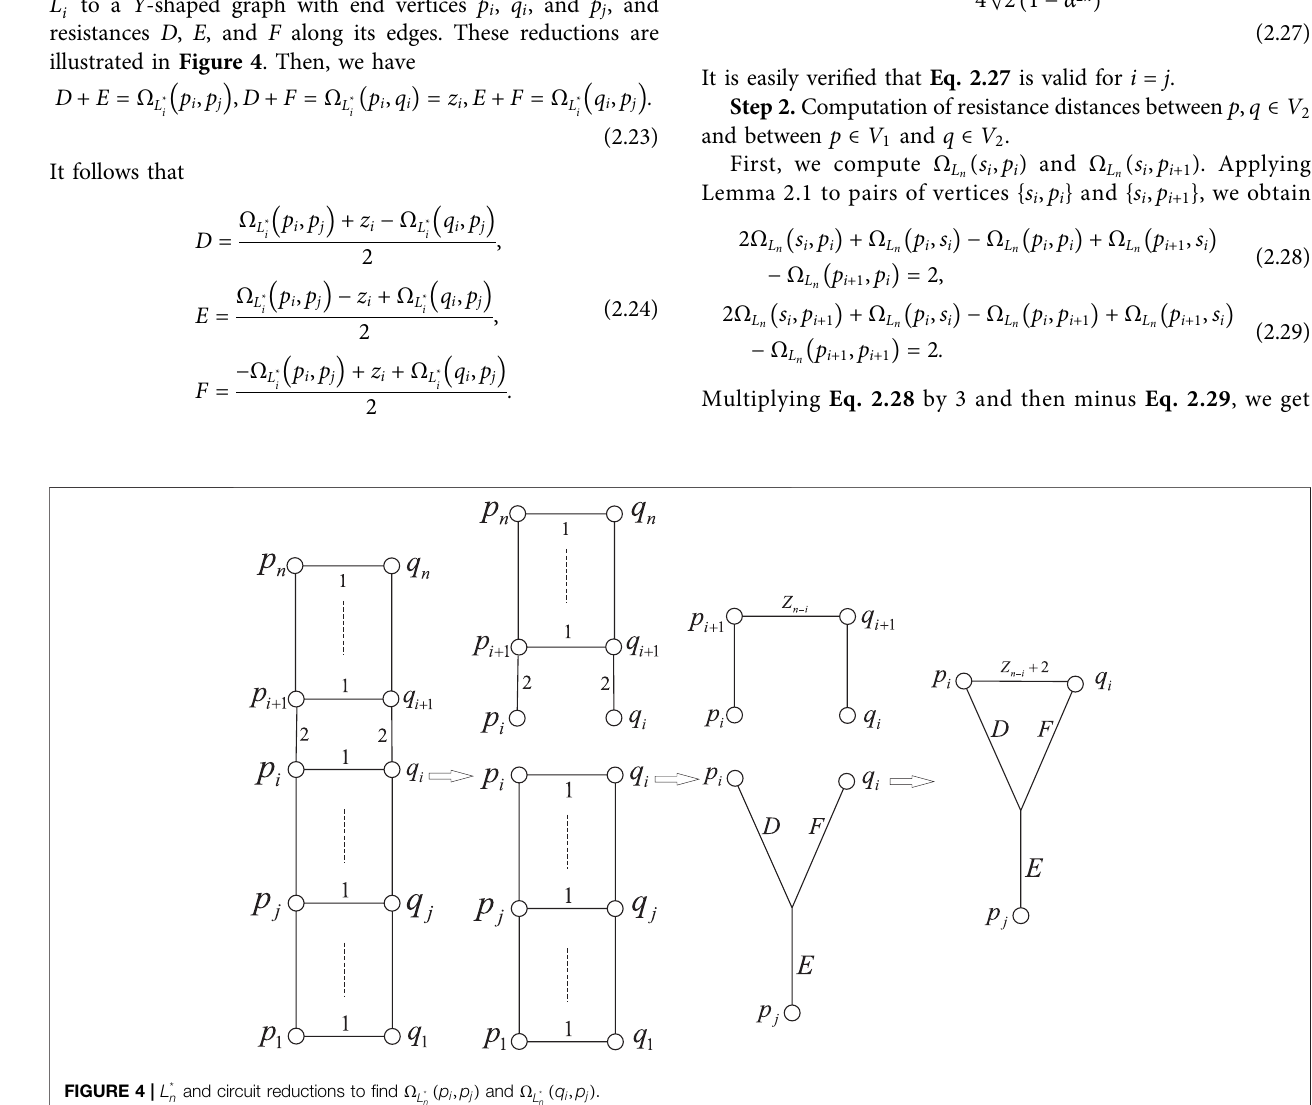
FIGURE 4 | L * n and circuit reductions to fi nd Ω L *